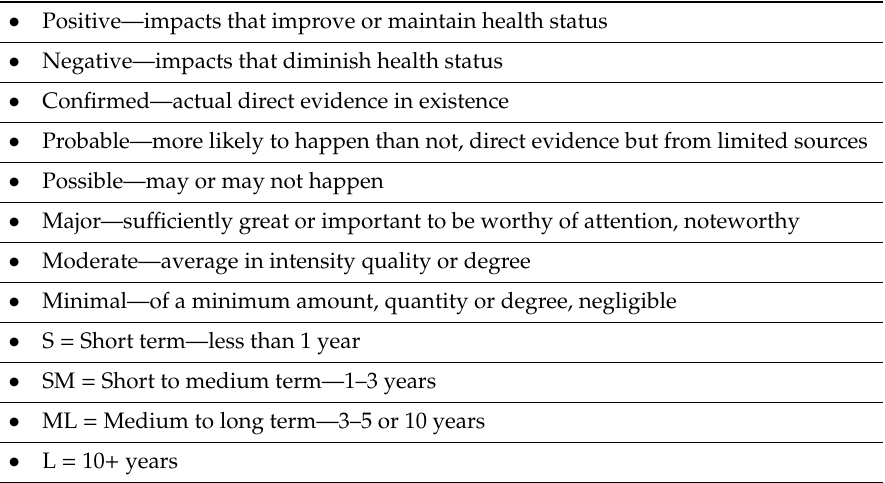
Table 1. Terminology: Characterisation of